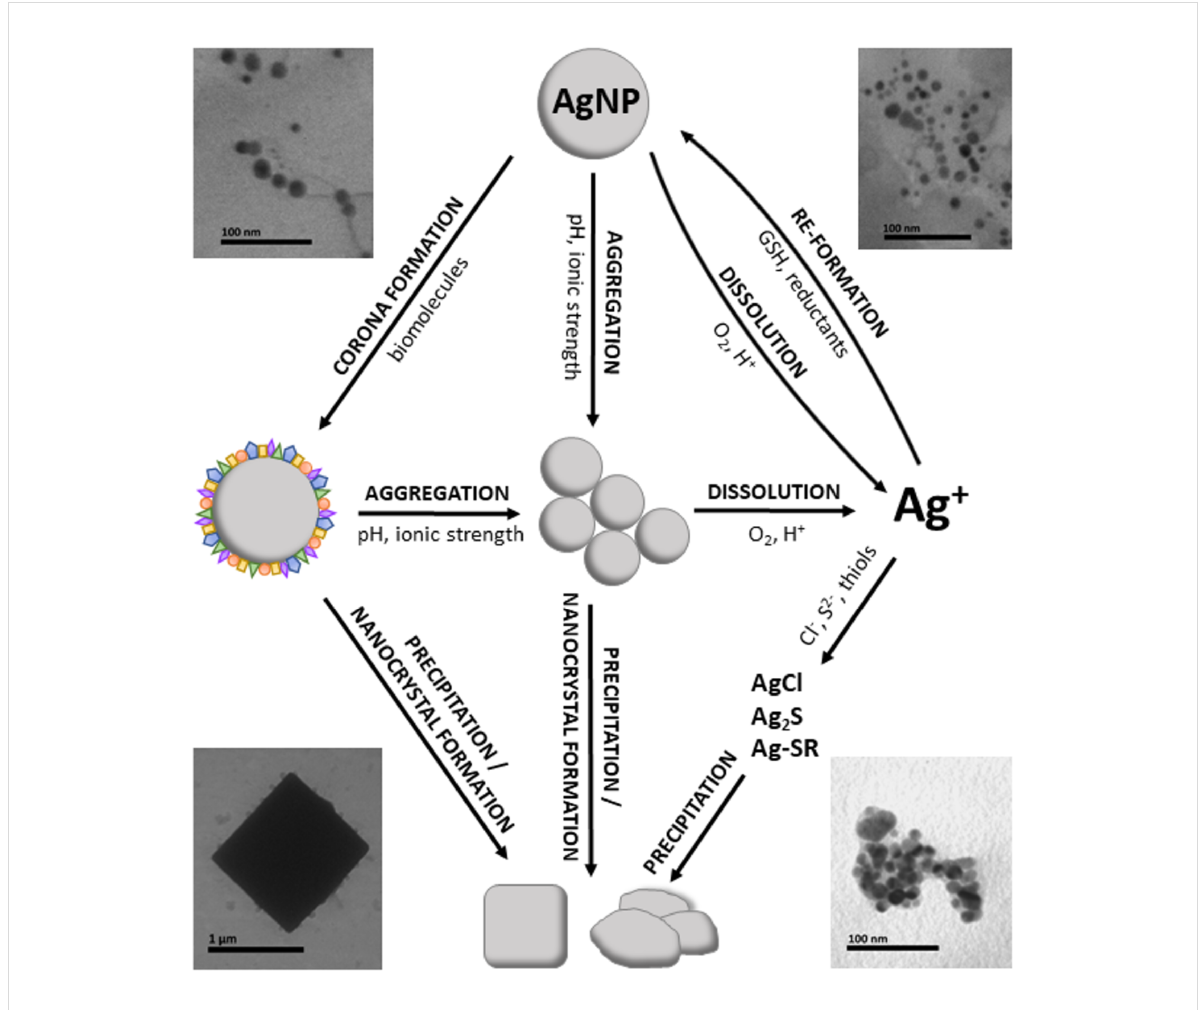
Figure 9: Biotransformation patterns of AgNPs in biological